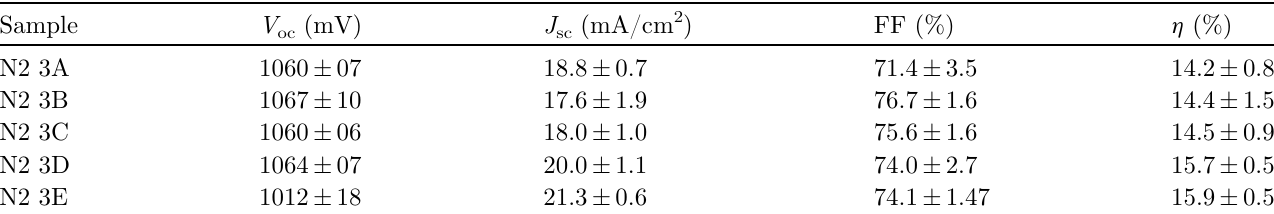
Table 4. Average performance of perovskite solar cells fabricated by USSC and high pressure gas quenching, with 1 M solution (with standard deviation).